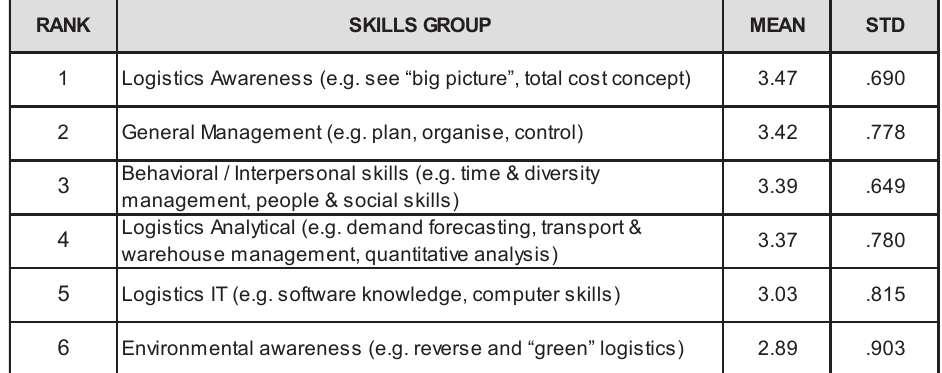
Table 3: Reliability analysis of the various skills groups